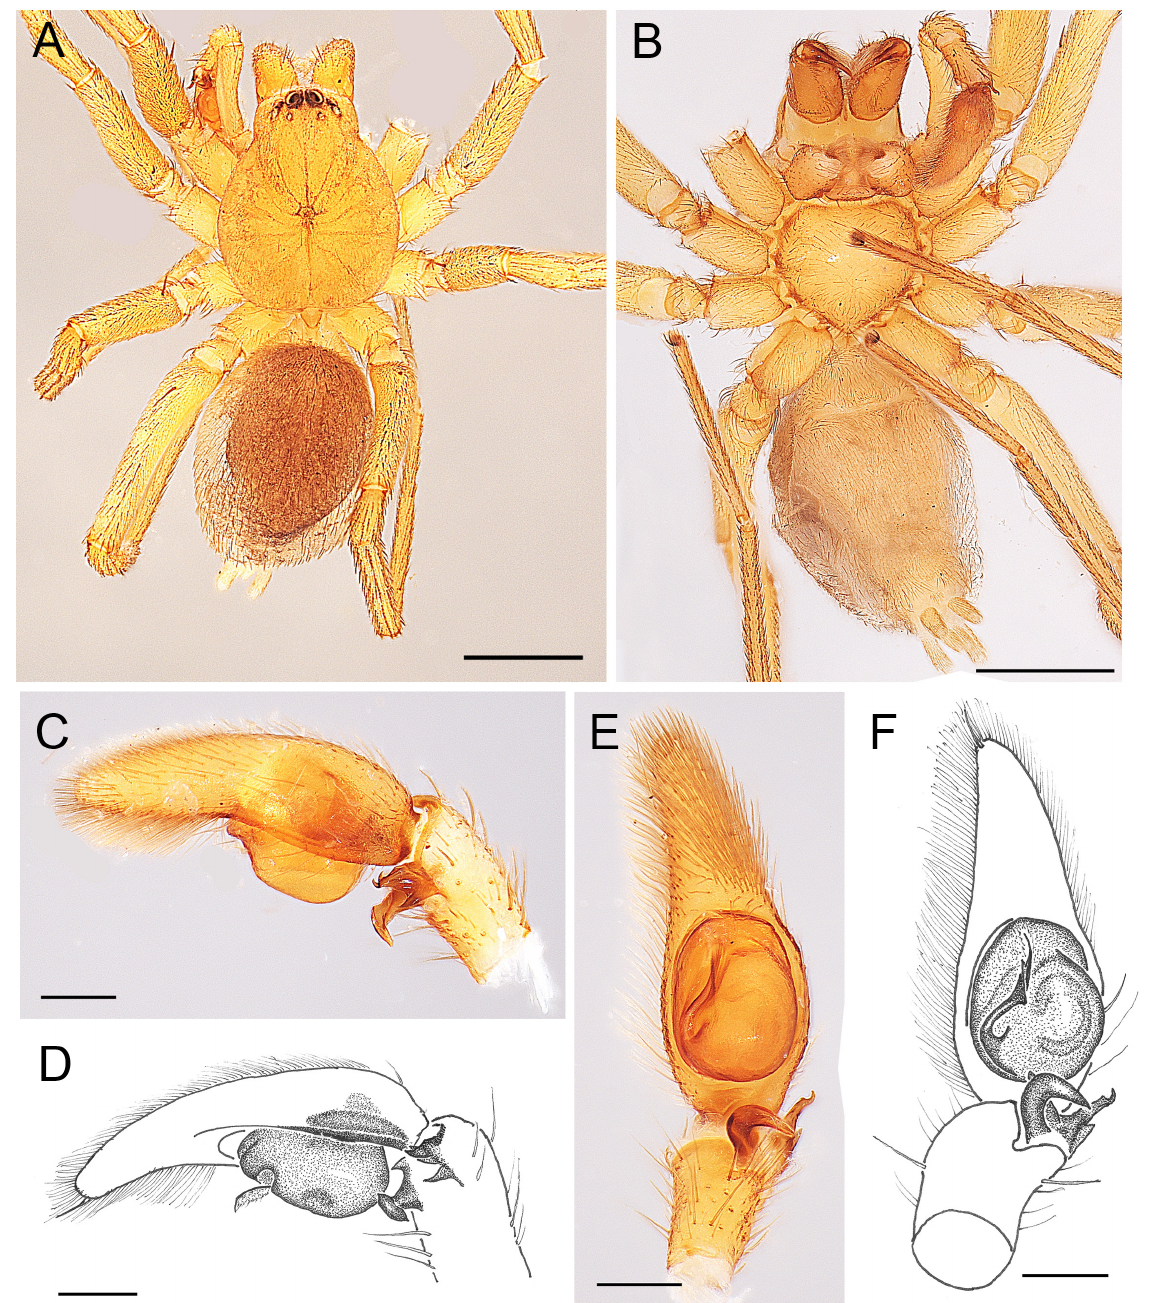
Fig. 20. Andromma didrepanum sp. nov., ♂, holotype (BE_RMCA_ARA.Ara 216034). A . Habitus, dorsal view. B . Same, ventral view. C–D . Left palp, retrolateral view. E–F . Same, ventral view. Scale bars: A–B = 1 mm; C–F = 0.2